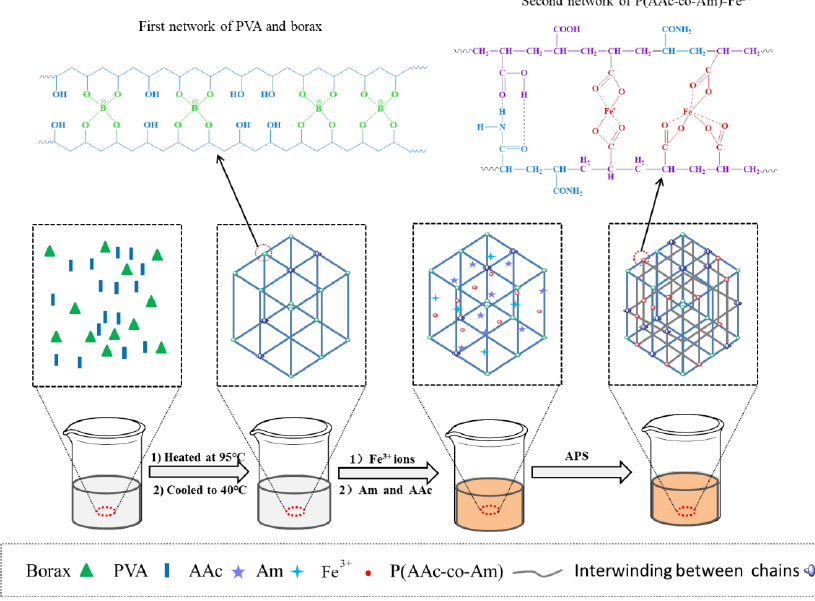
Scheme 1. Schematic diagram of synthesis of P(AAc-co-Am) / PVA double network